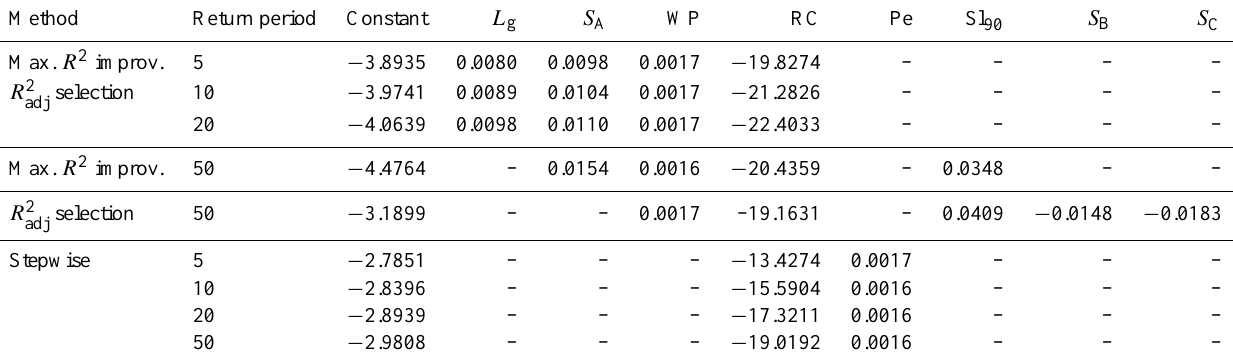
Table 2. Regression coefficients of the global model by method of regression and return period. The general equation